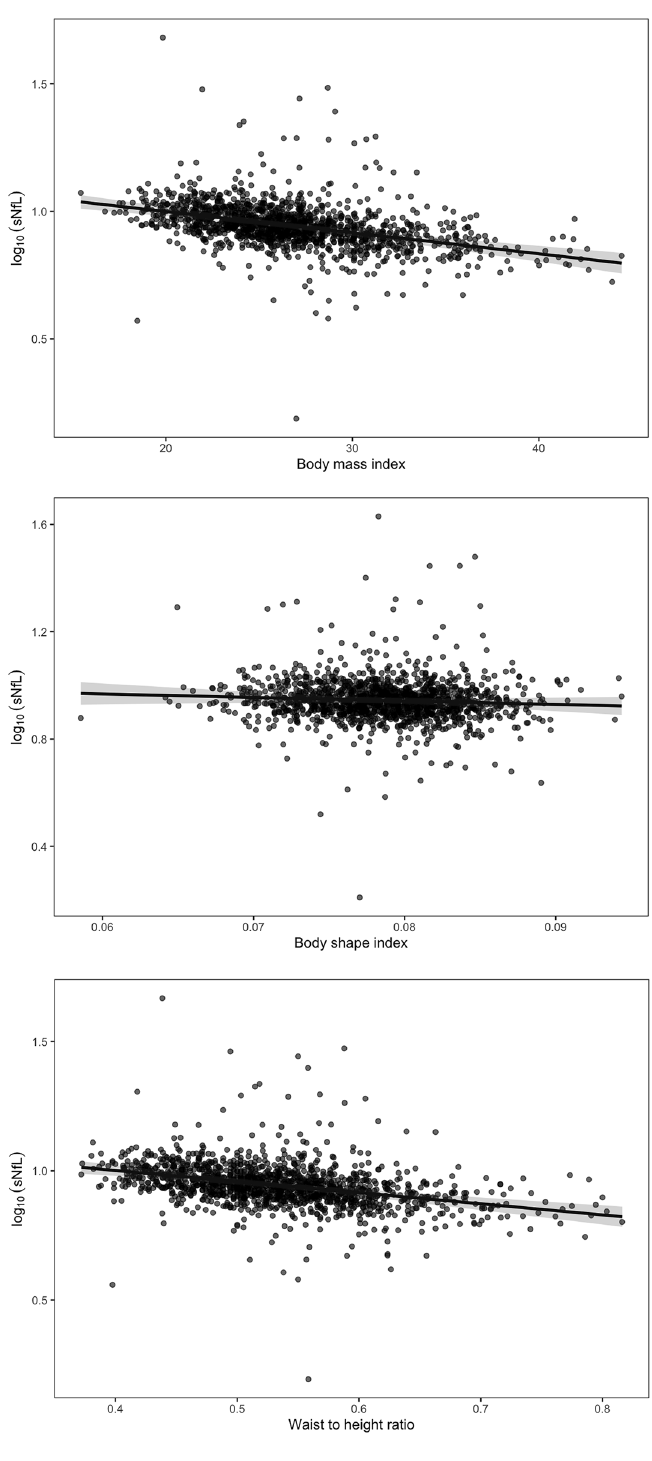
Figure 2. Partial residual plots showing the sex- and age-adjusted, separate associations of sNfL with body mass index, body shape index, and waist-to-height ratio. The grayish shaded areas indicate the 95% confidence